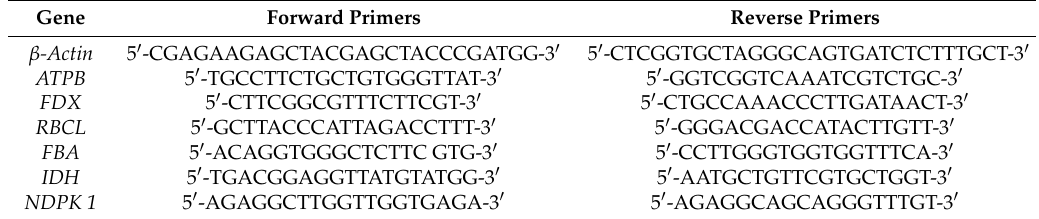
Table 4. The nucleotide sequences of the PCR primers used to assay the gene expression by quantitative real-time